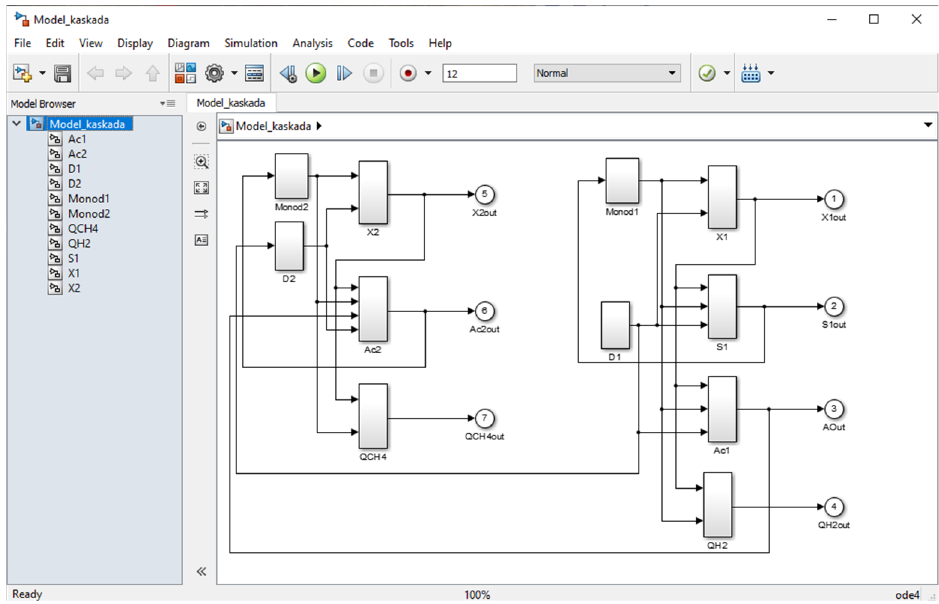
Figure 1. Mathematical model of corn steep liquor TSAD process ((1)–(9)) described in Simulink.